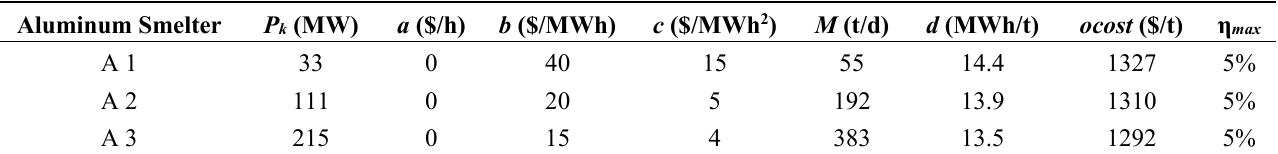
Table 5. Aluminum smelter agent parameters for the provision of AS.